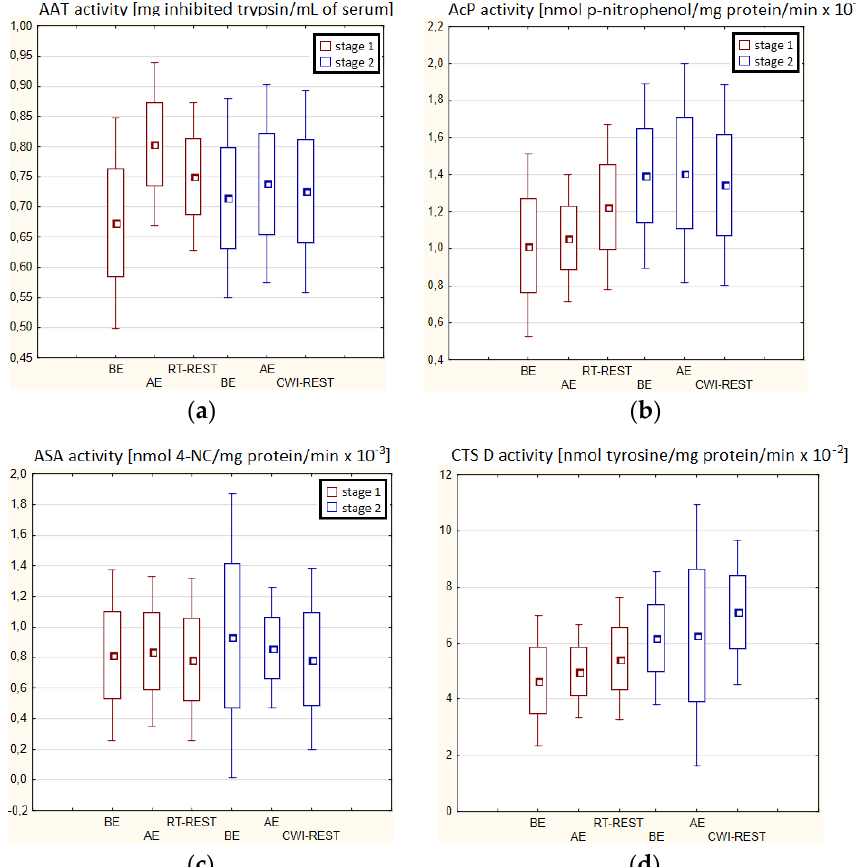
Figure 4. The activities of α 1-antytrypsin and lysosomal enzymes in blood serum of novices ( n = 23) in Experiment I: ( a ) AAT activity; ( b ) AcP activity; ( c ) ASA activity; ( d ) CTS D activity. Data are presented in